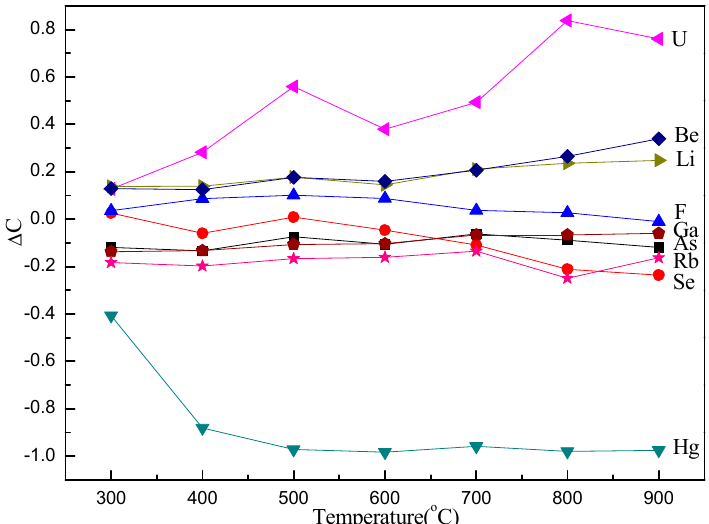
Figure 1. Δ C of trace elements (TEs) in raw coal and char samples obtained from pyrolysis at different temperatures at a fast heating rate.